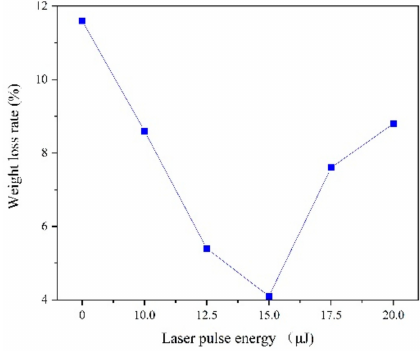
Figure 9. Corrosion behavior of coatings with varying laser